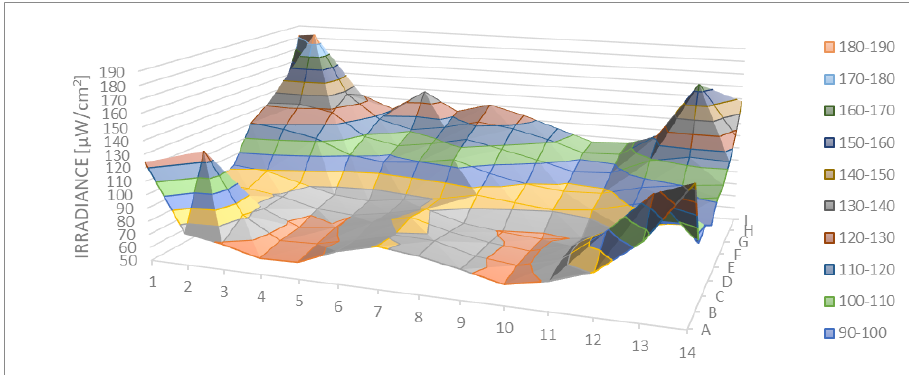
Figure 5. Spatial distribution of direct irradiance on the exposed surface ( µ W/cm 2 ). The average of the direct irradiance was 97.7 µ W/cm 2 with a standard deviation of 24.9 µ W/cm 2